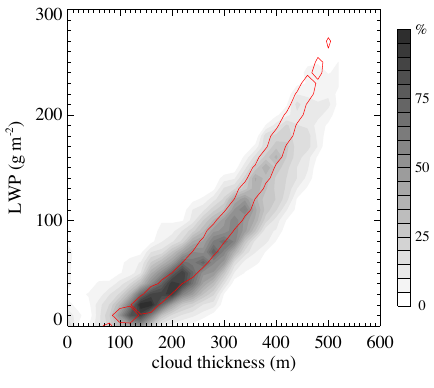
Fig. 14. Retrieved (filled grey-scale contours) and adiabatic (red contour lines) LWP relative percentages as a function of cloud thickness, based on bins of (10m, 20gm − 2 ) in cloud thickness and LWP. Total N retrieved =32492 and N adiabatic =24188. 5660LWPs were retrieved without coincident cloud thicknesses and are not in-